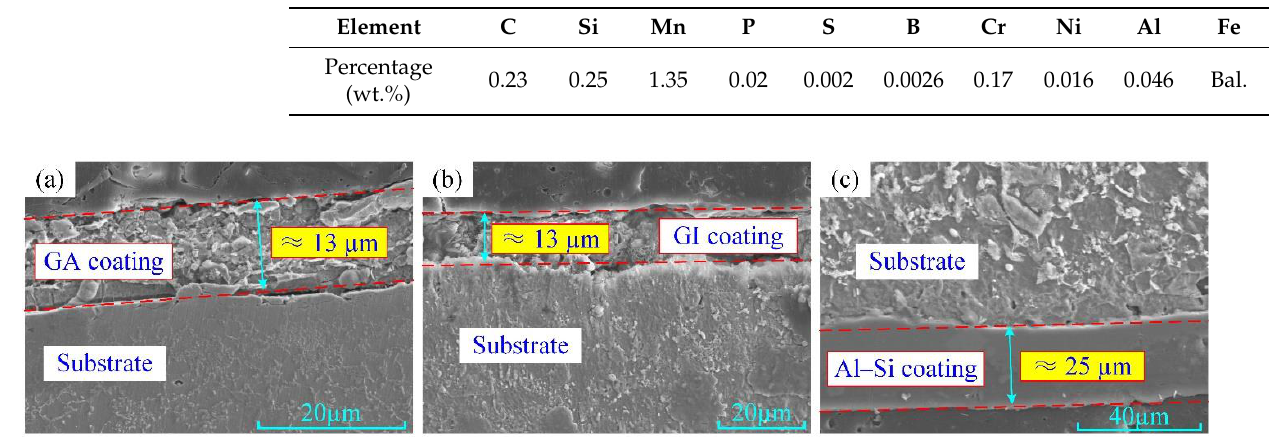
Table 1. The chemical compositions of boron steel B1500HS.